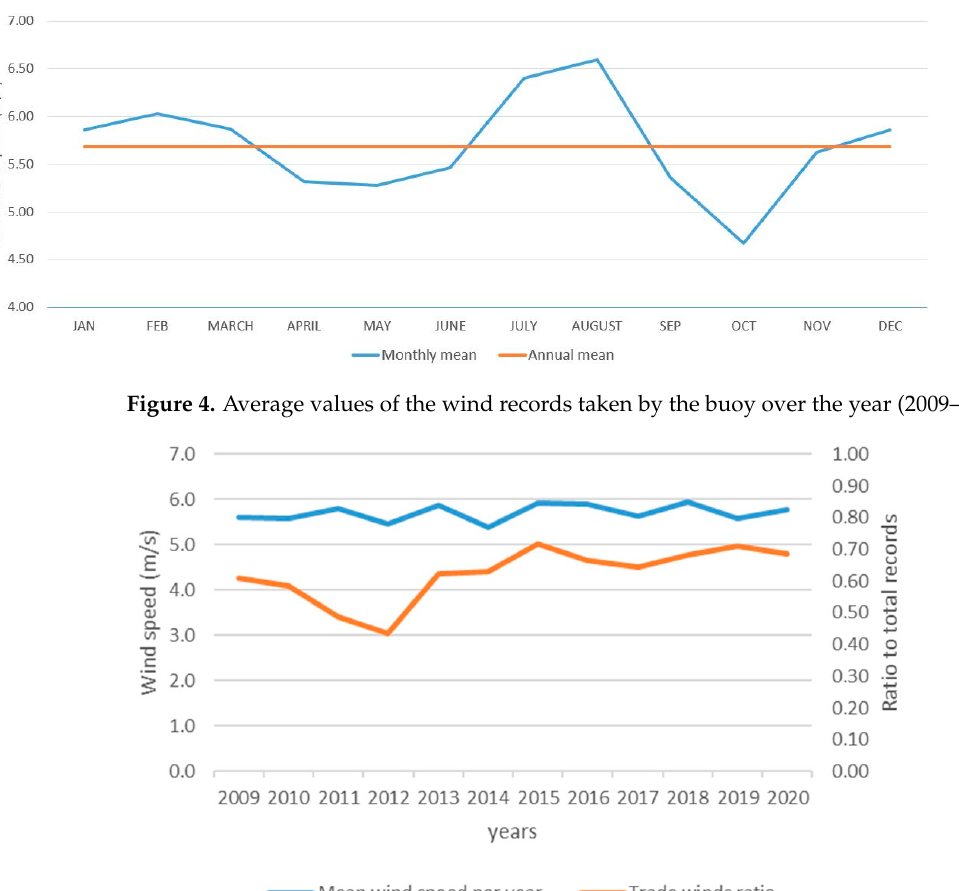
Figure 5. Interannual variation of wind speed and proportion of trade winds (2009–2020 period).